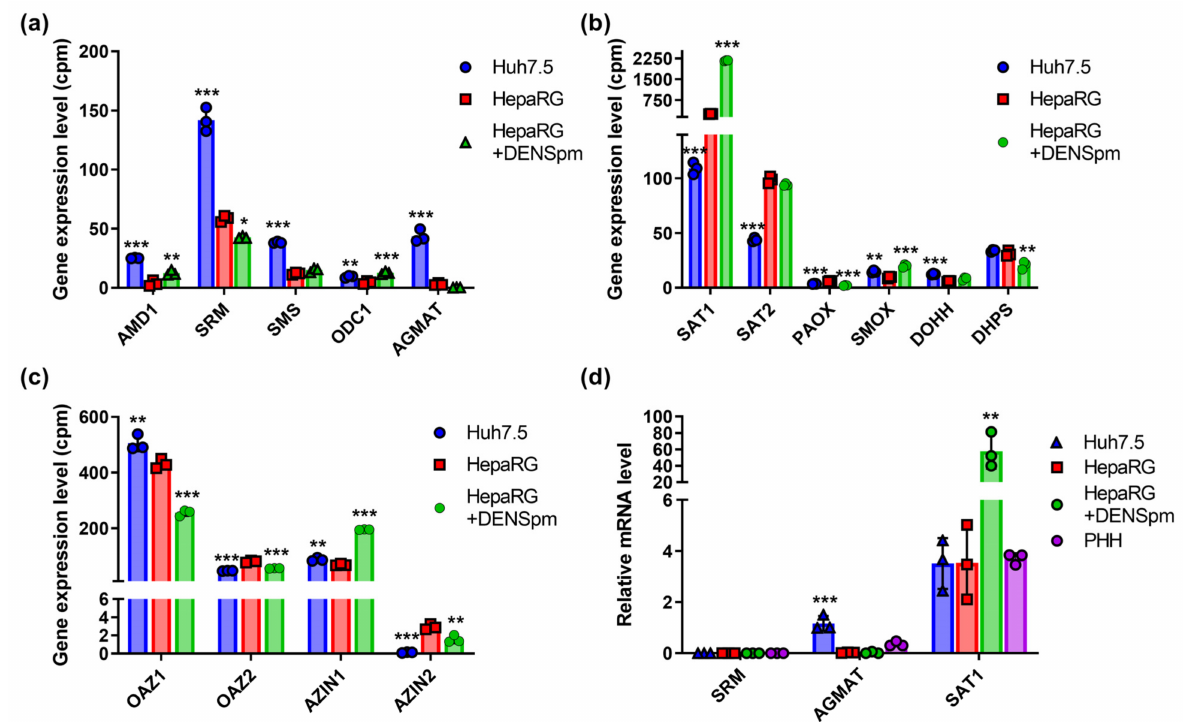
Figure 4. Relative mRNA levels of enzymes of polyamines metabolism in hepatoma Huh7.5 cells, hepatocyte-like HepaRG cells, and HepaRG cells treated with DENSpm, assessed by RNAseq analysis. Levels of the mRNA of polyamine-metabolizing enzymes ( a ), enzymes of urea cycle ( b ), or proline metabolism ( c ). ( d ) Relative levels of mRNA of metabolic genes in these cells and PHH assessed by RT-qPCR and normalized to the levels of GUS mRNA. Bars are means ± S.D. Statistical significance comparison of cells to differentiated HepaRG cells. * p < 0.05, ** p < 0.01, *** p <